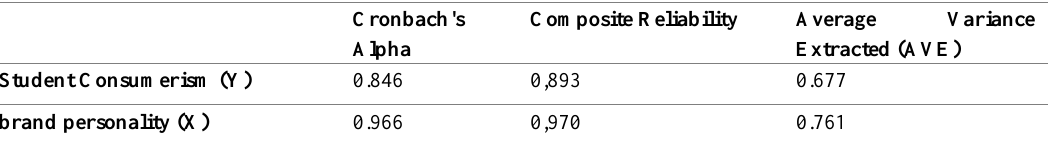
Table 2 : Construct Reliability and Validity